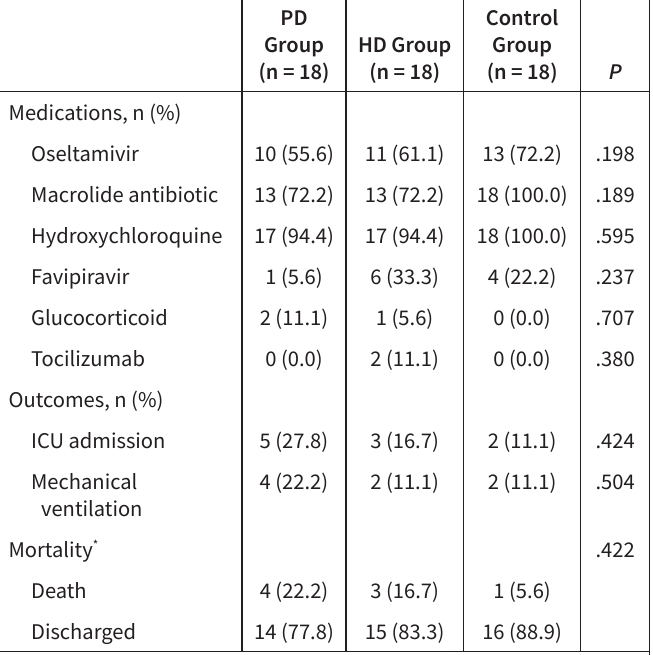
Table 2. The Medication Used for the Treatment of COVID-19 Infection and the Outcome Data of the